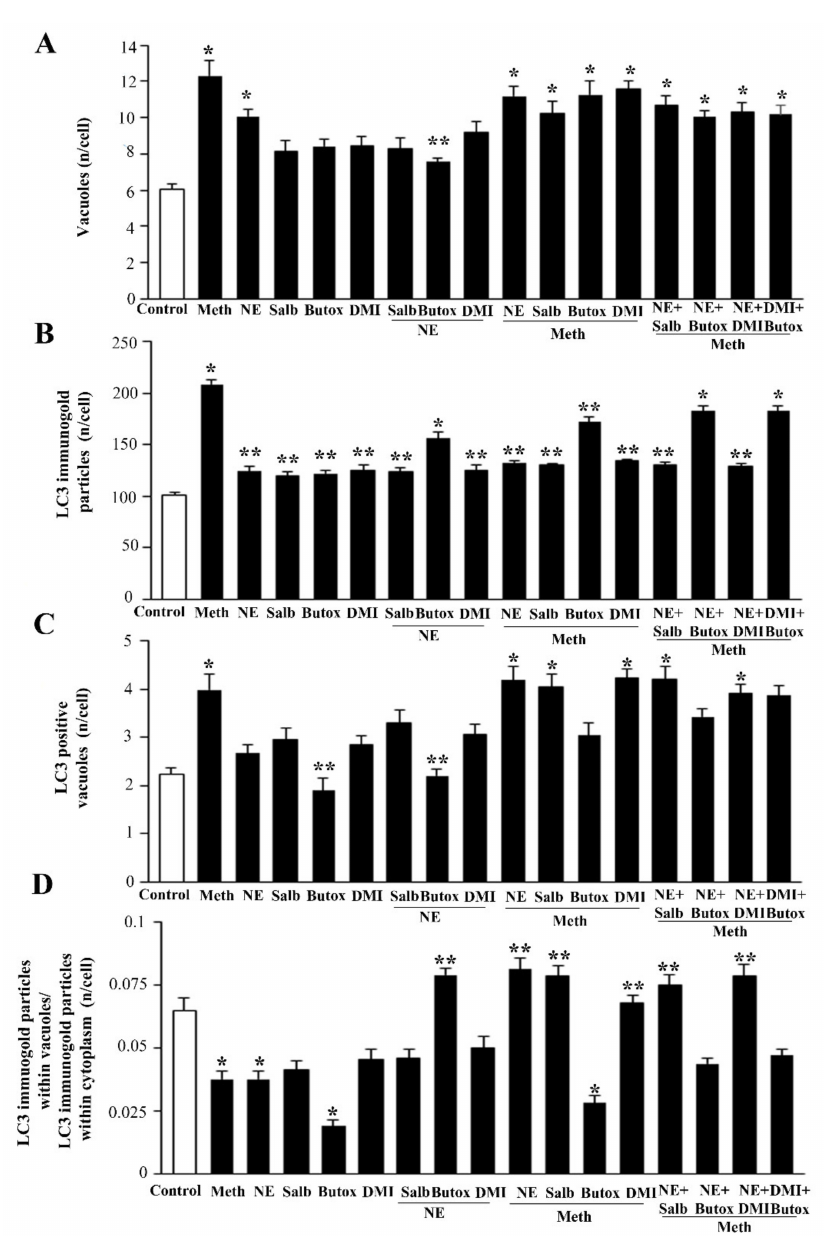
Figure 13. Effects of NE, Meth, β 2-AR ligands, and DMI on autophagy vacuoles and LC3 com- partmentalization. The graphs show ( A ) the amount of authentic autophagy vacuoles (defined as double/multiple membrane vacuoles containing LC3 molecules); ( B ) the amount of whole cell LC3 immunogold particles; ( C ) LC3 positive vacuoles; ( D ) the ratio between LC3 within vacuoles and whole cell LC3. Measurements are obtained by ultrastructural morphometry where the quantitative measurement of vacuoles and stoichiometrically identified LC3 particles by immunogold are counted. The graphs show that Meth increases the amount of autophagy-like vacuoles and autophagy vacuoles along with whole cells LC3 particles compared with control. Nonetheless, the ratio of LC3 within vacuoles and LC3 in the whole cell is strongly diminished. This indicates a de-polarization of LC3 from vacuoles to the cytosol. Such an effect is reversed by NE, which by itself does not increase polarization compared with controls. Salbutamol replicates the data obtained with NE, as it does DMI, while butoxamine occludes these effects. Numbers are given as the mean+SEM of autophagy-like vacuoles/autophagy vacuoles/cytosolic LC3 particles/vacuolar LC3 particles per cell, which were counted in 50 cells per group. Inferential statistics was carried out with ANOVA with Scheff è ’s post hoc analysis. (DF = 16). * p < 0.05 compared with controls. ** p ≤ 0.05 compared with